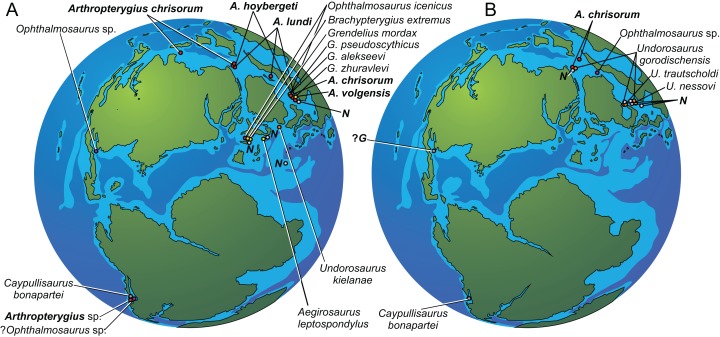
Distribution of ophthalmosaurids in the Kimmeridgian—early Middle Volgian (Dorsoplanites panderi Chron) time interval (A), and Middle Volgian (Virgatites virgatus Chron)—Late Volgian (late Tithonian to early Berriassian time interval) (B).Abbreviations: N, representatives of Nannopterygius clade; G, possible Grendelius. Reconstruction is modified from Zakharov et al. (2014).